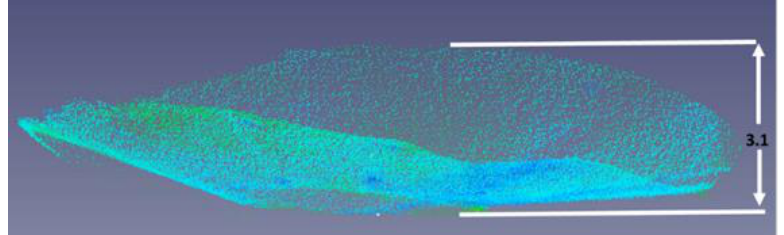
Figure 5. Depth of sour hole in dry scan (depth is in inch) [35,36] (used with permission).